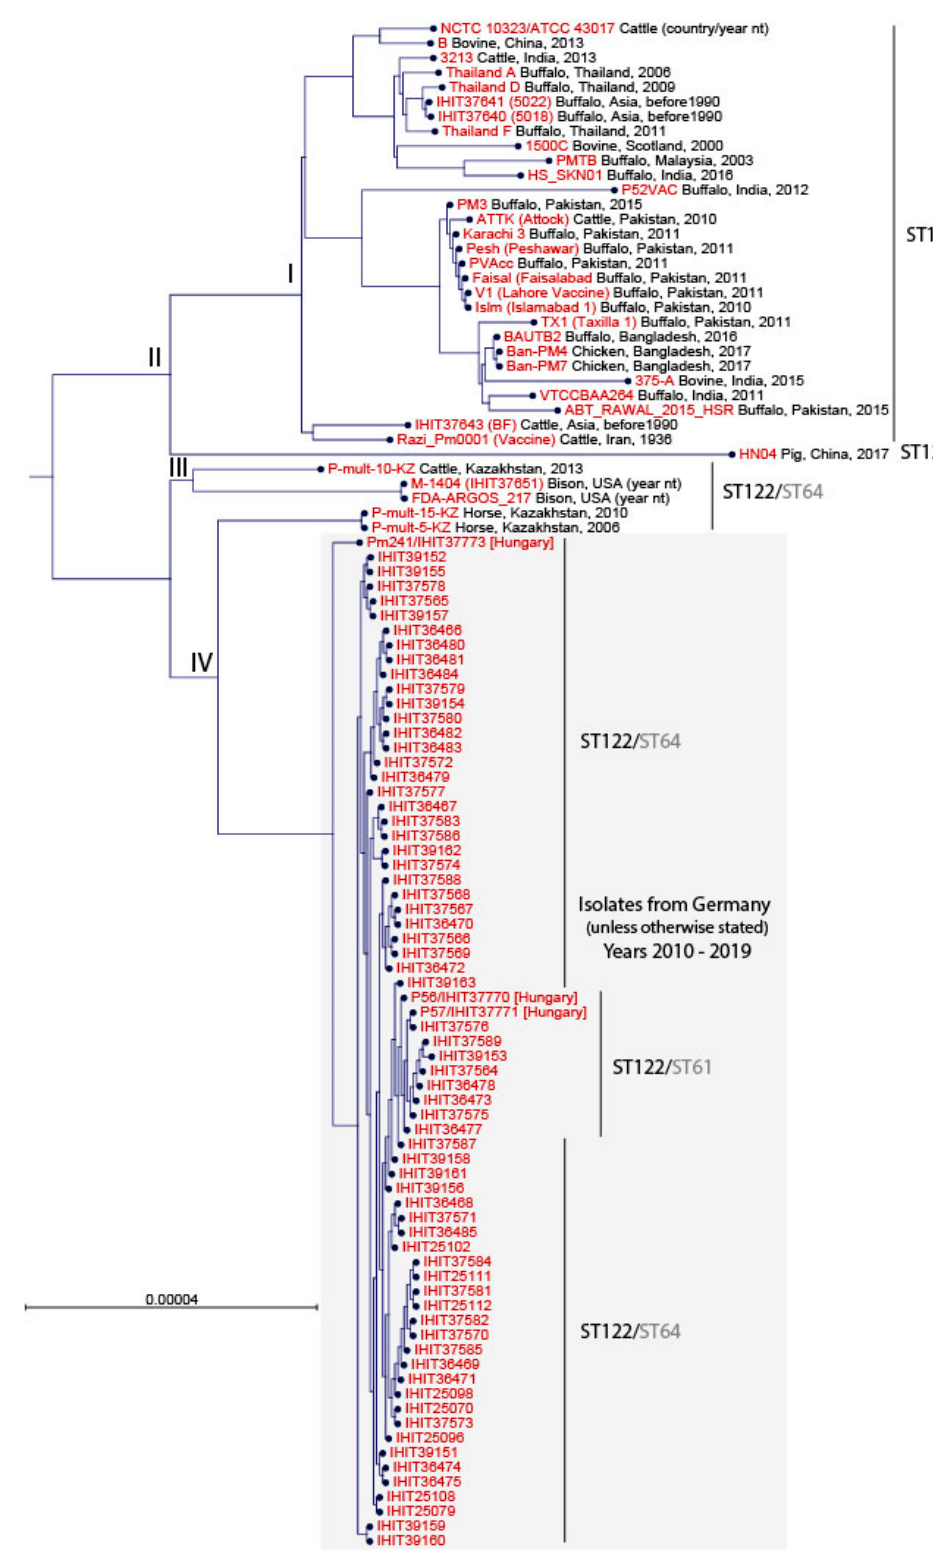
Figure 2. Neighbour-joining phylogenetic tree constructed from the core genome (1806 orthologous genes) of 103 Pm B isolates. Multilocus sequence types (ST RIRDC /ST mh ) are indicated on the right, next to the isolate identifier.